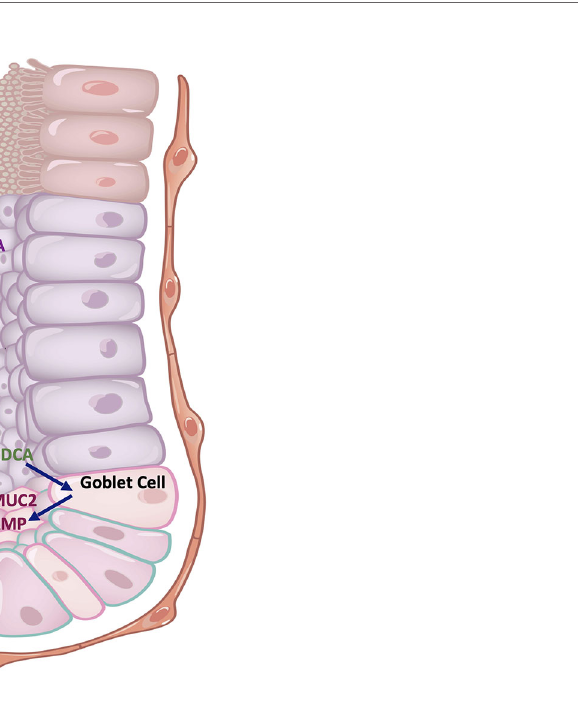
FIGURE 4 | Cell type-speci fi c effects of BAs on the intestinal epithelium. The SBAs, LCA and DCA, inhibit the production of pro-in fl ammatory cytokines IL1 b and IL8 in Caco-2 cells that resemble enterocytes. They also promote stem cell growth in the intestinal crypts by acting on TGR5. CDCA acts on goblet cells to promote MUC2 expression and antimicrobial peptide (AMP) release. Key: Blue arrows - stimulatory interactions, Red arrow - inhibitory interaction. DCA, deoxycholic acid; LCA, lithocholic acid; CDCA, chenodeoxycholic acid; MUC2, mucin 2; AMP, antimicrobial peptides; TGR5, Takeda G protein-coupled receptor 5; IL1 b , interleukin 1- beta; IL18, interleukin